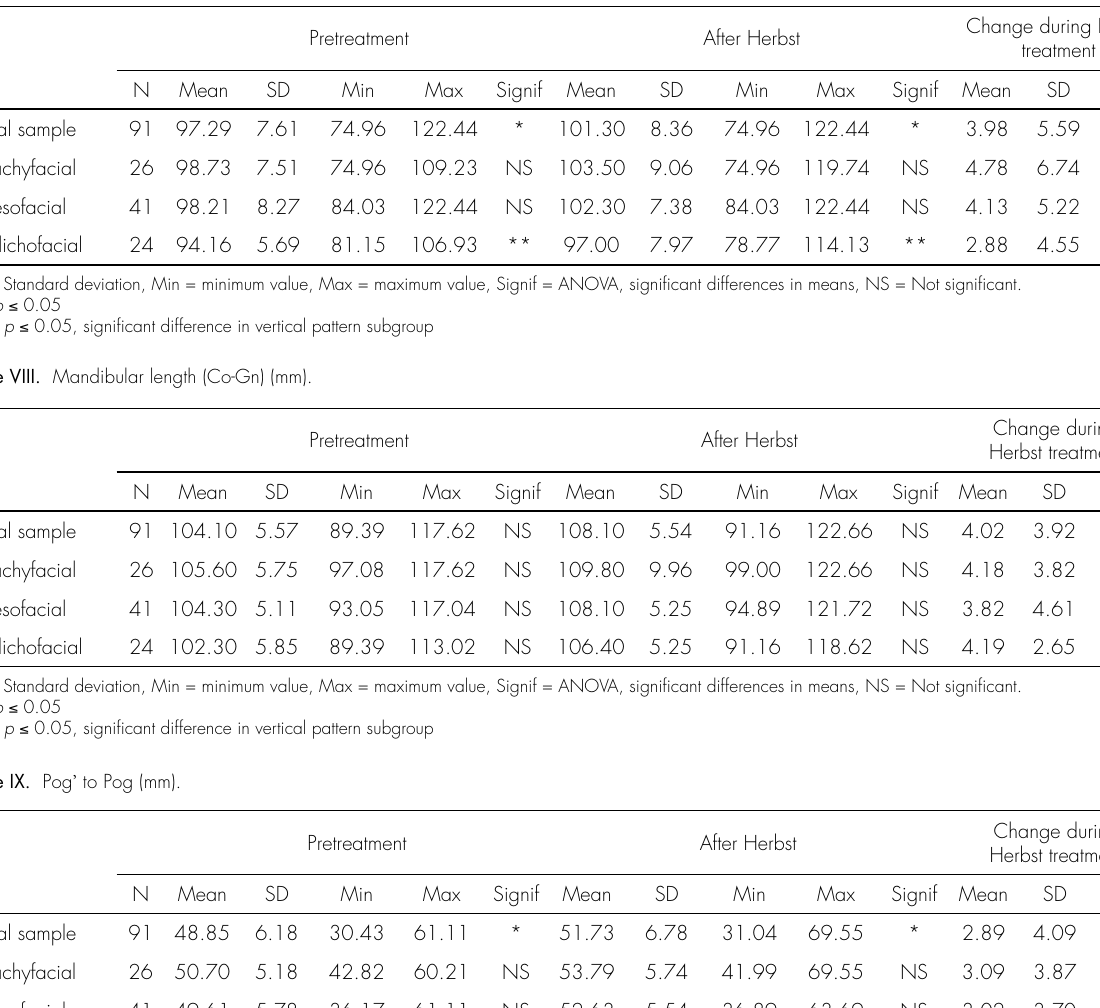
Table VII. Lower incisor to mandibular plane (degrees).